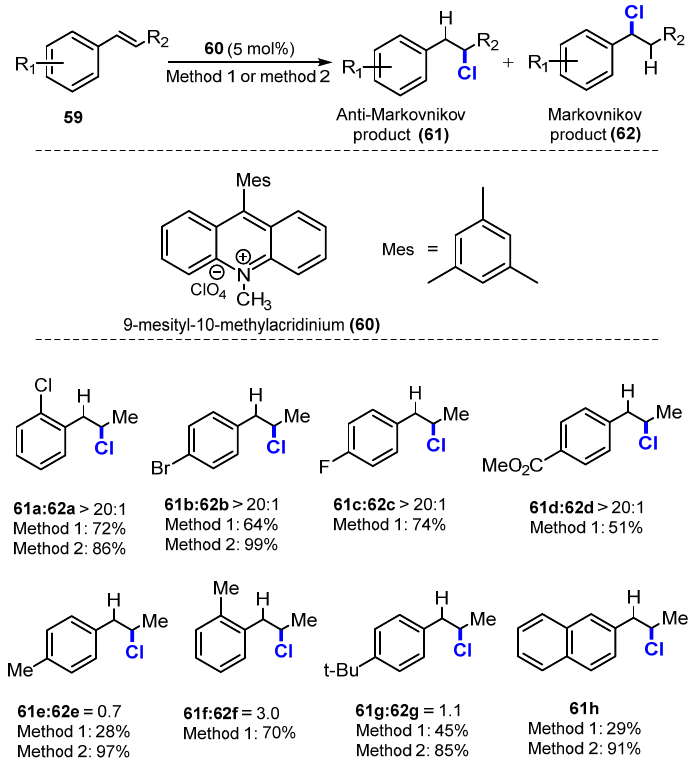
Scheme 16. Photoredox anti-Markovnikov hydrochlorination of